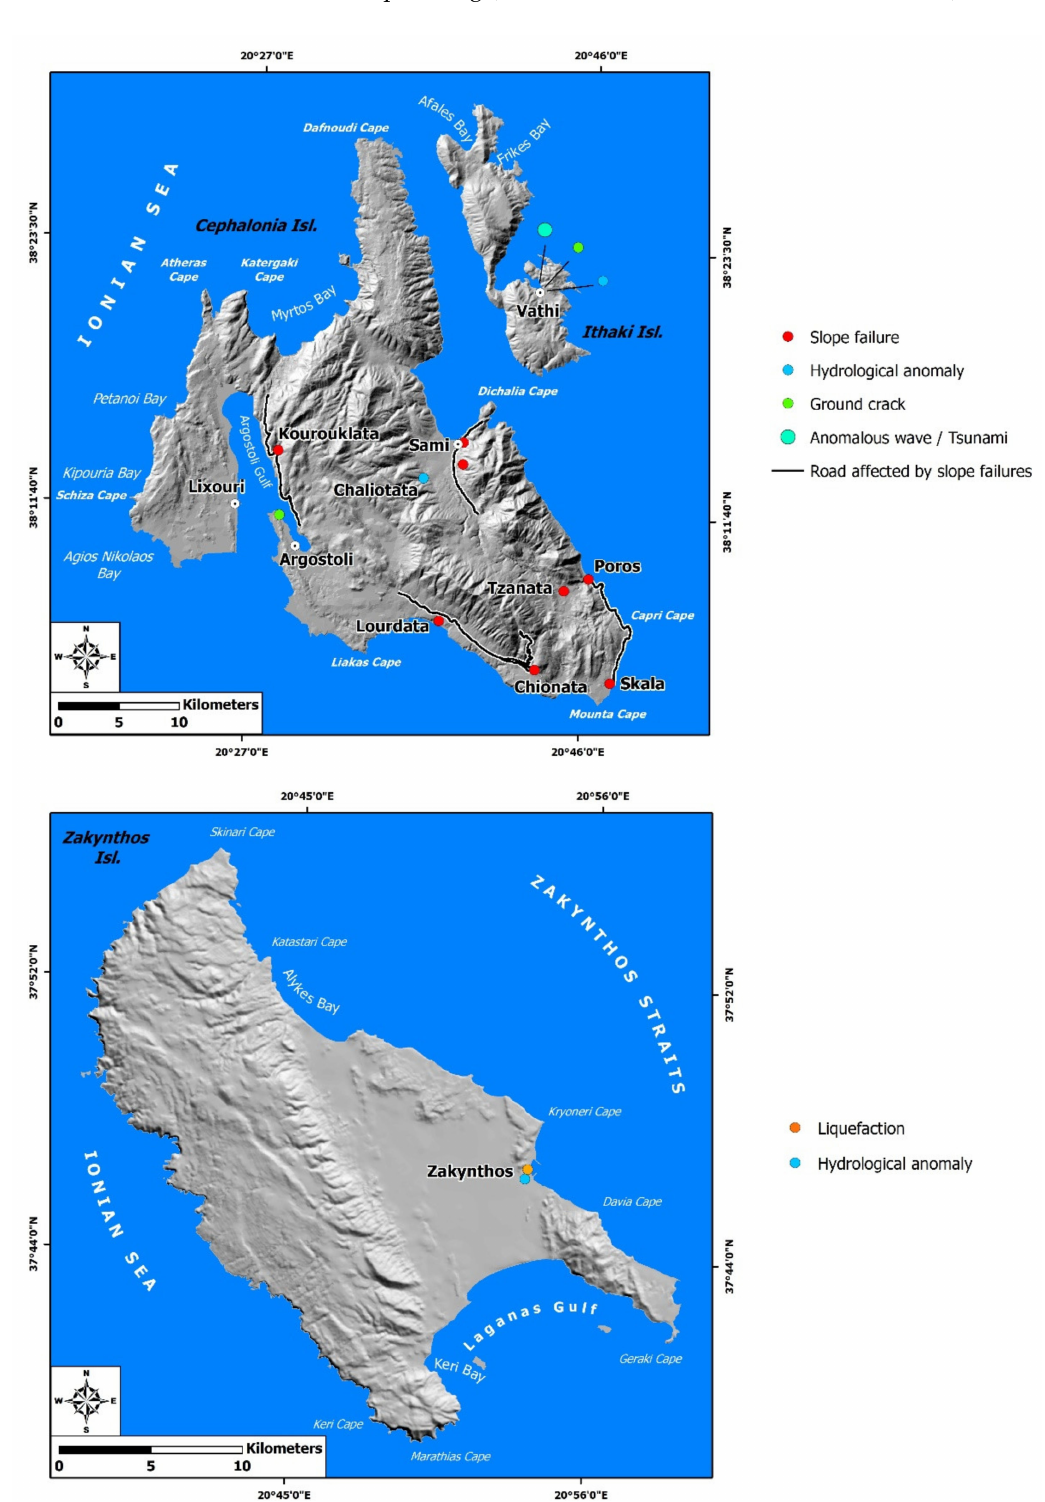
Figure 8. Secondary environmental effects induced by the 11 August 1953 Ionian Sea earthquake in Cephalonia, Ithaki and Zakynthos